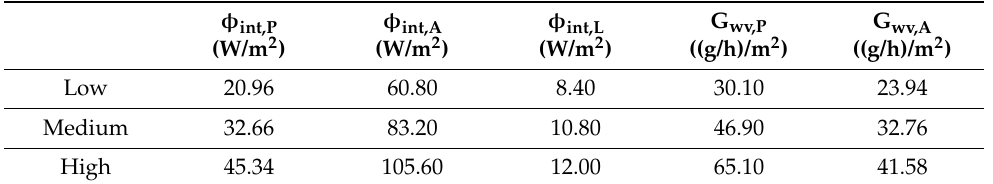
Table 3. Daily thermal sensible gains for occupancy (P = people), appliances (A), lighting (L), and latent gains for people and